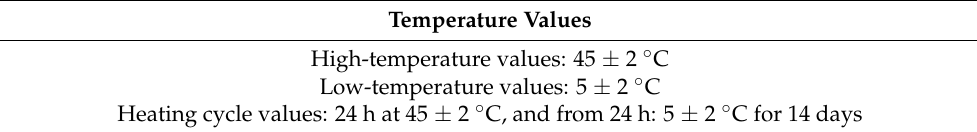
Table 5. Temperature reference values for thermal stress